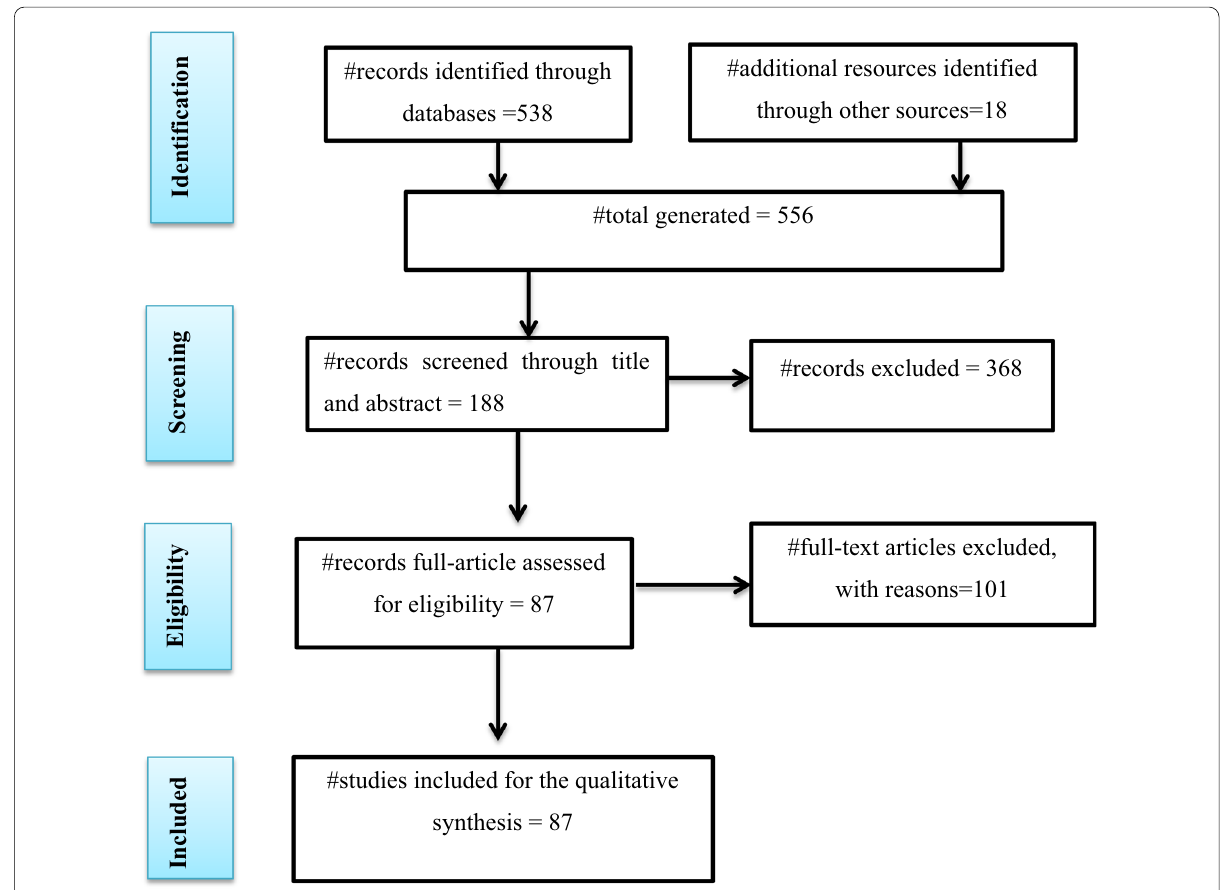
Fig. 1 Flowchart for selecting eligible studies on the challenges and opportunities of COVID-19 lockdown on natural